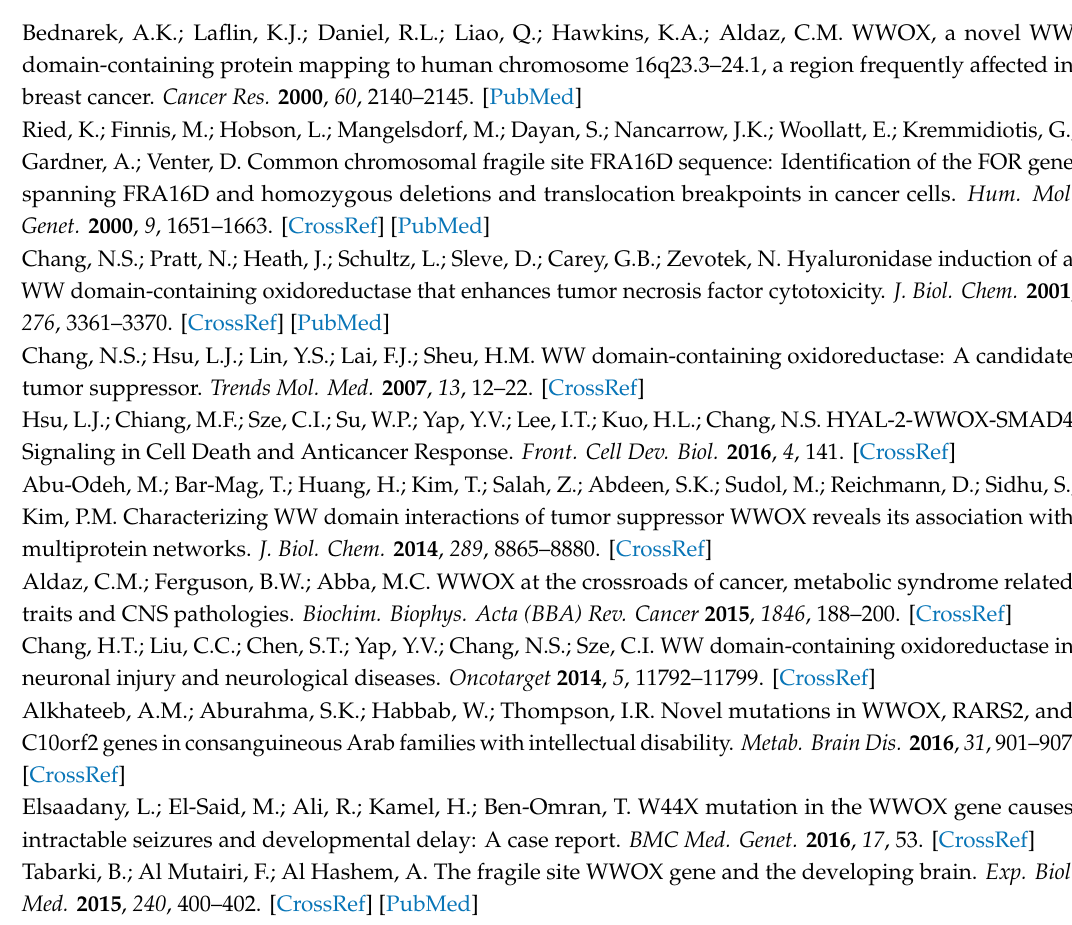
Figure S1: WWOX is clustered in the cell membrane. Figure S2: WWOX is clustered in the cell membrane. Figure S3: Expression of pS14-WWOX in the cancer stem cell spheres. Figure S4: Stages in ceritinib-mediated 4T1 breast cancer stem cell sphere explosion and death. Figure S5: pS14-WWOX7-21 peptide strongly protects breast 4T1 stem cell spheres from explosion and death caused by ceritinib. Video S1: Ceritinib induces individual breast 4T1 cell apoptosis and stem cell sphere explosion and death; Video S2: WWOX286-299 antiserum did not block ceritinib-induced death of breast 4T1 cells. Video S3: WWOX7-21 antiserum blocked ceritinib-induced death of breast 4T1 cells. Video S4: Ceritinib induced death of breast 4T1 cells at room temperature. Video S5: WWOX7-21 peptide accelerated ceritinib-induced death of breast 4T1 cells at room